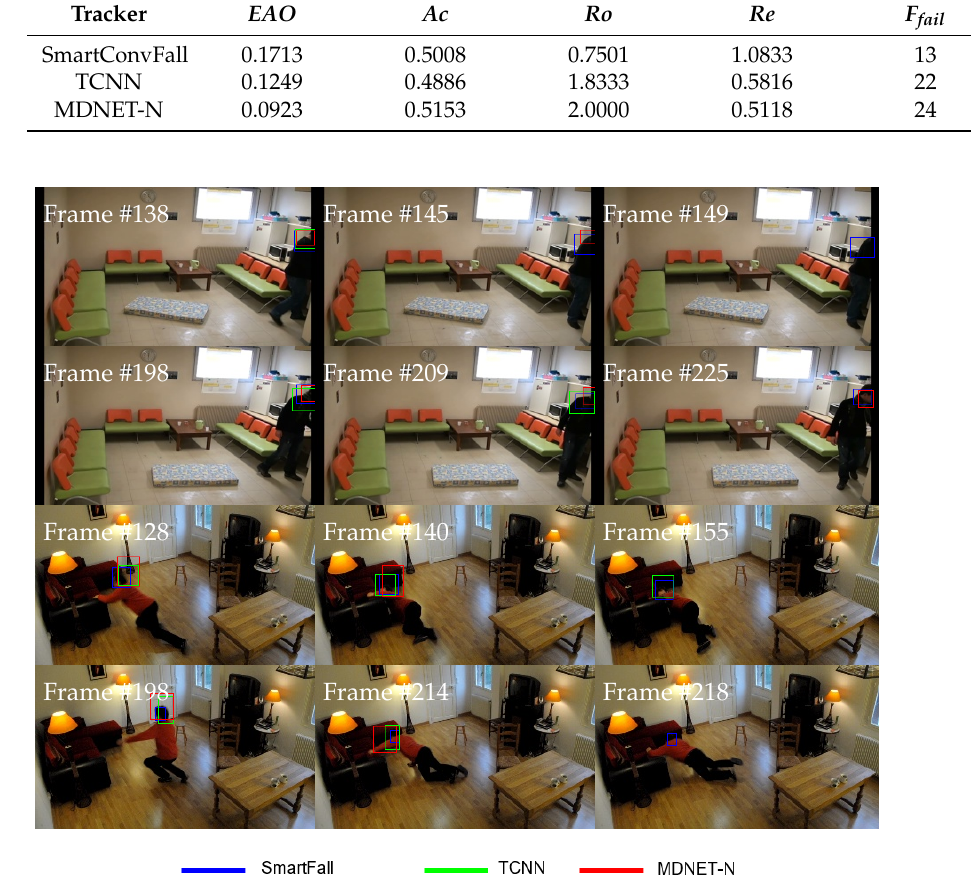
Figure 18. Comparison of B output of all tested trackers for occlusion noise